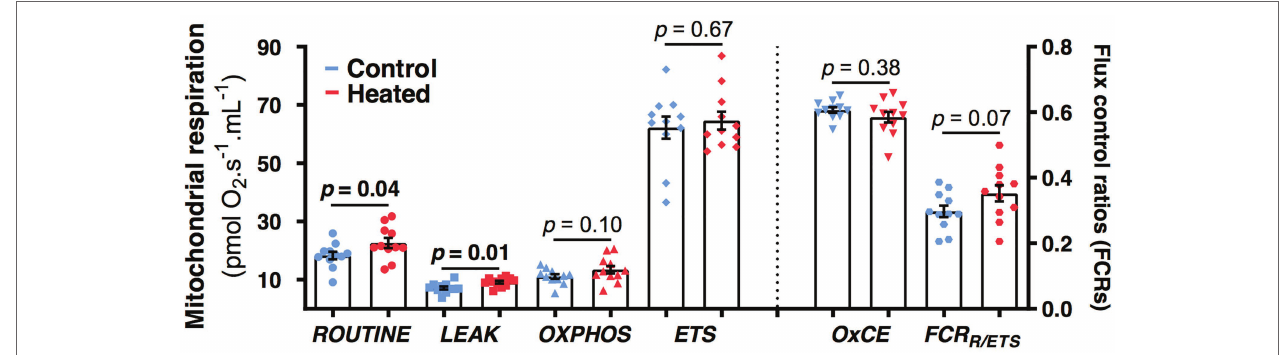
FIGURE 4 | Effects of early-life heat waves exposure in zebra finch on blood cells mitochondrial physiology measured at day 80 (i.e., 2 months after the treatment ended). ROUTINE represents the endogenous mitochondrial respiration, LEAK the proton-leak related mitochondrial respiration, OXPHOS the ATP-synthesis related mitochondrial respiration, and ETS the maximal mitochondrial respiration. OXPHOS coupling efficiency ( OxCE ) is an index of mitochondrial efficiency to produce ATP and FCR R/ETS an index of the mitochondrial reserve capacity. Individual data points are presented along with their mean ± SE and describe oxygen consumption not corrected by protein content (see Materials and Methods and Results sections for details on